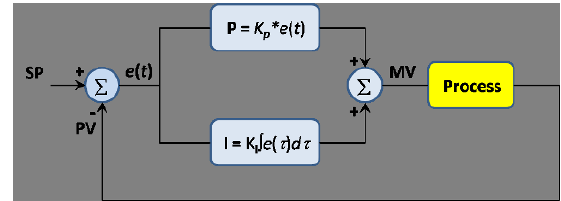
Figure 18. Generic PI Controller